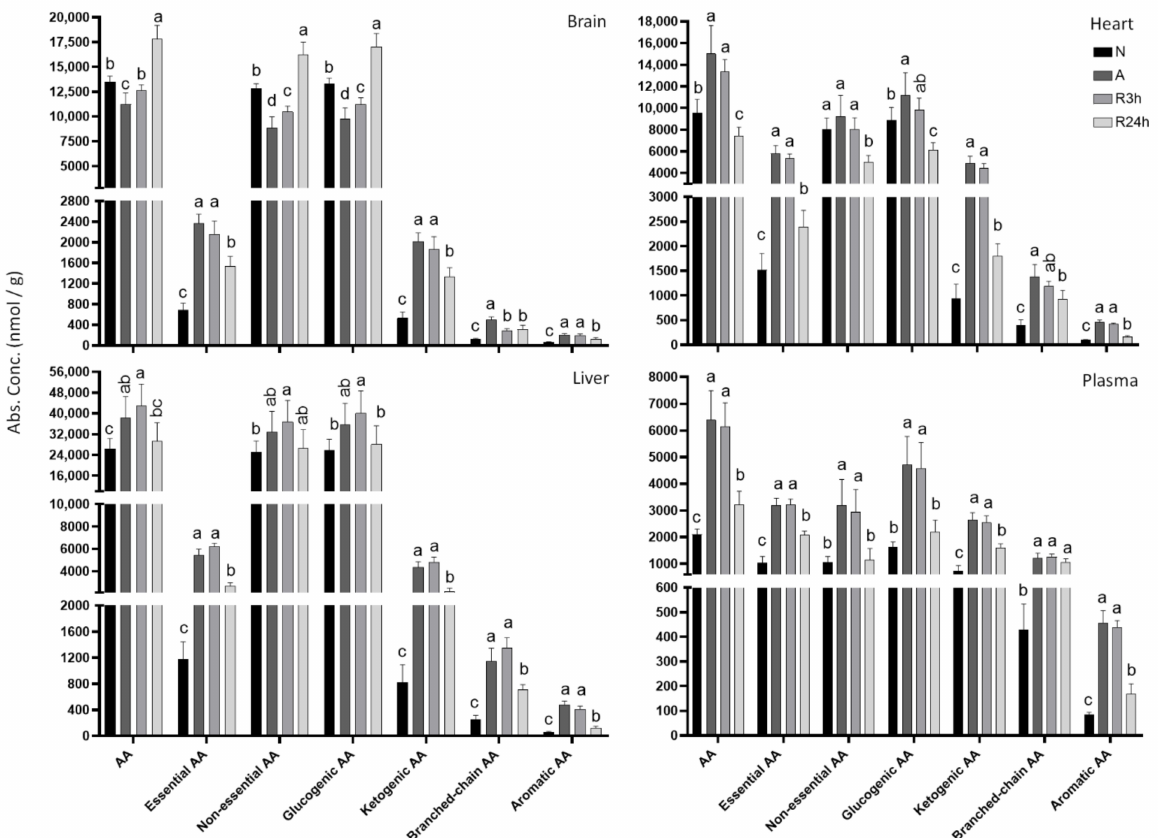
Figure 9. Amino acid totals. Graphs of absolute concentrations of total amino acids for brain, heart, liver, and blood plasma. N, normoxia (control); A, anoxia; R3h, 3 h reoxygenation; R24h, 24 h reoxygenation. Different letters indicate statistical differences between groups calculated using one-way ANOVA with Tukey’s post-hoc ( p -value ≤ 0.05). Note that y-axis limits are different. Data are presented as means ± S.D. Values as reported by